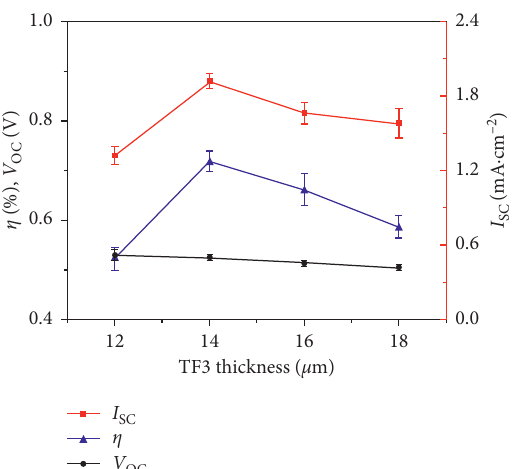
Figure 6: Photoelectric parameters of the TF3 film with different thicknesses (standard deviation is the calculate values based on the measurements of four parallel solar cells).